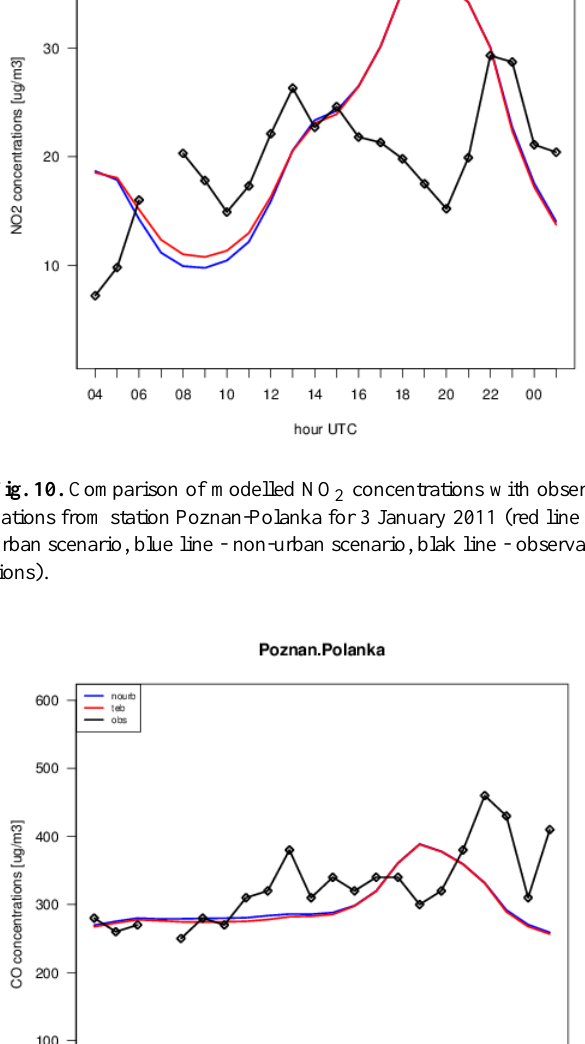
Fig. 11. Comparison of modelled CO concentrations with observa- Figure 11 Comparison of modelled CO concentrations with observations from station tions from station Poznan-Polanka for 3 January 2011 (red line - urban scenario, blue line - non-urban scenario, black line - observa- Poznan-Polanka for 3rd of January 2011 (red line – urban scenario, blue line = non-urban